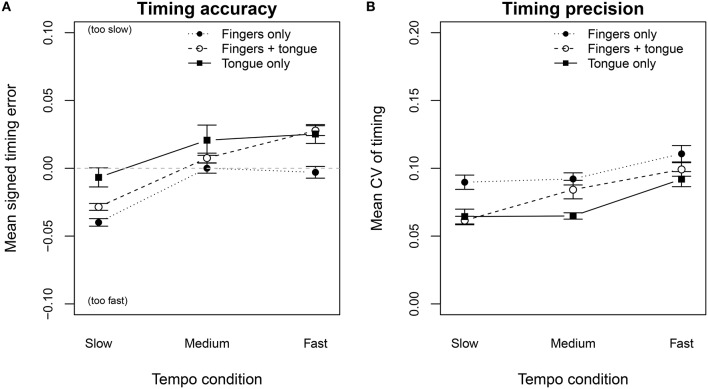
Timing error (A) and coefficient of variation (B), for the technical-exercise task, played in three tempo conditions, grouped by the effectors required to perform the tone sequence on a Bb-flat clarinet. Error bars show the standard error of the mean.